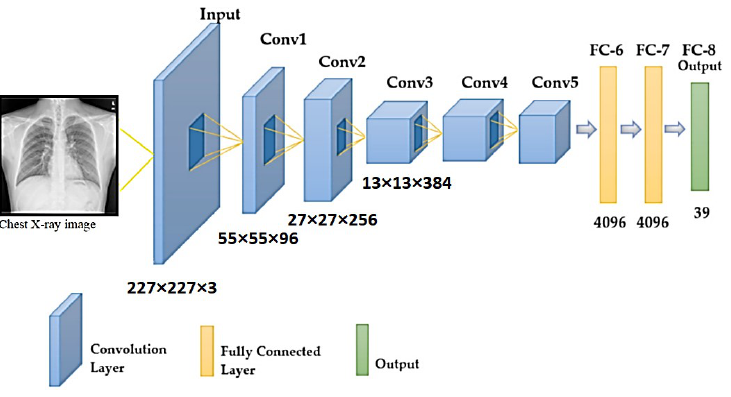
Figure 4. Schematic illustration of the AlexNet architecture.